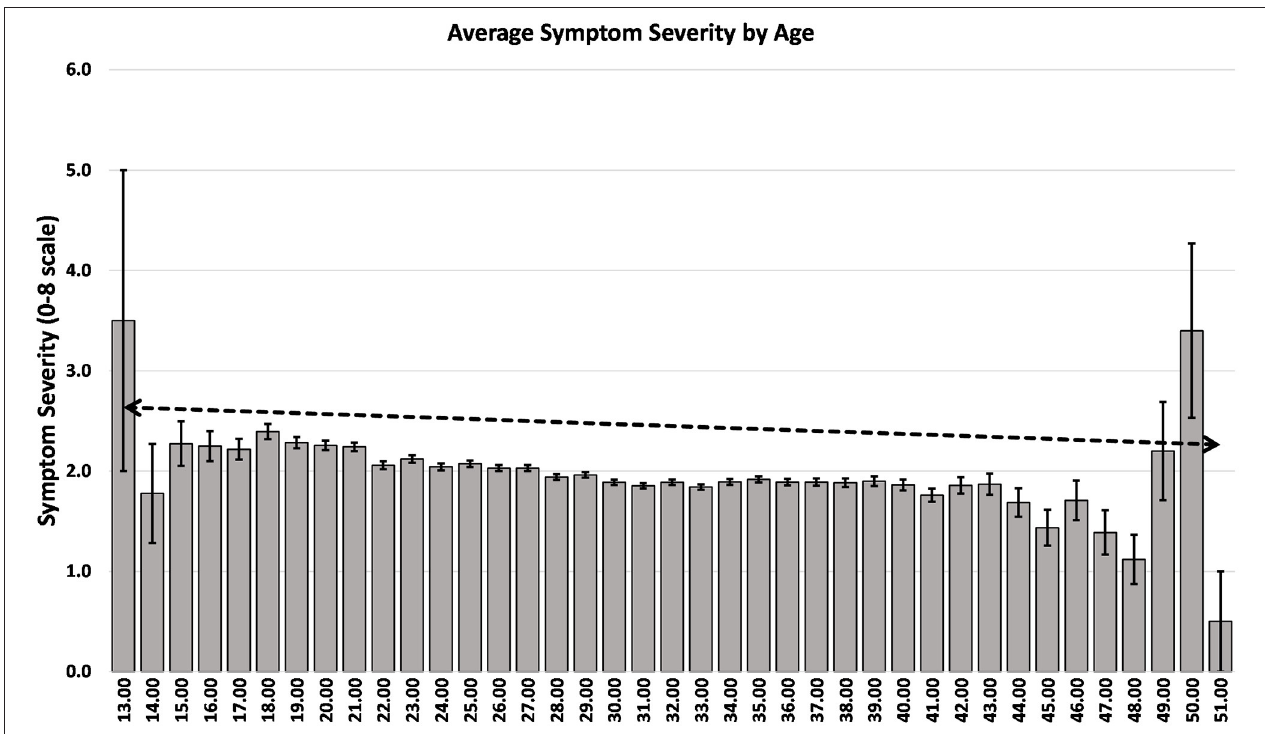
FIGURE 4 | Average symptom severity of PRAMS respondents across age of